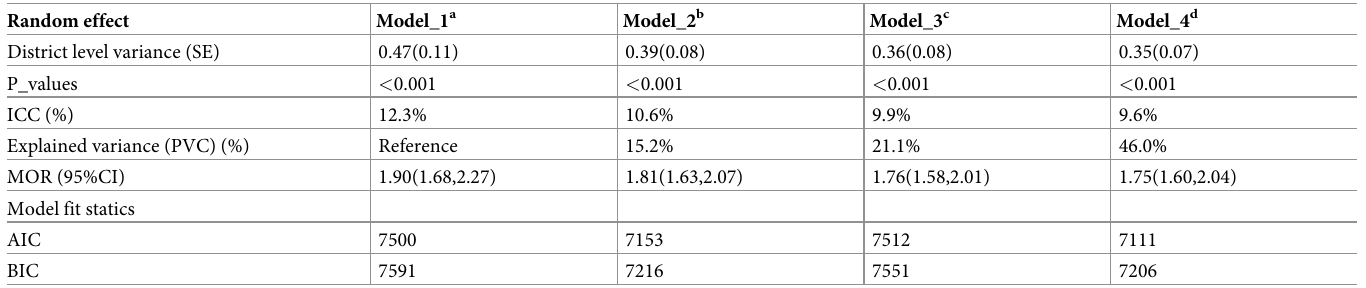
Table 6. Results from the random intercept model (a measure of variation) for the timing of death at the district level using multilevel logistic regression